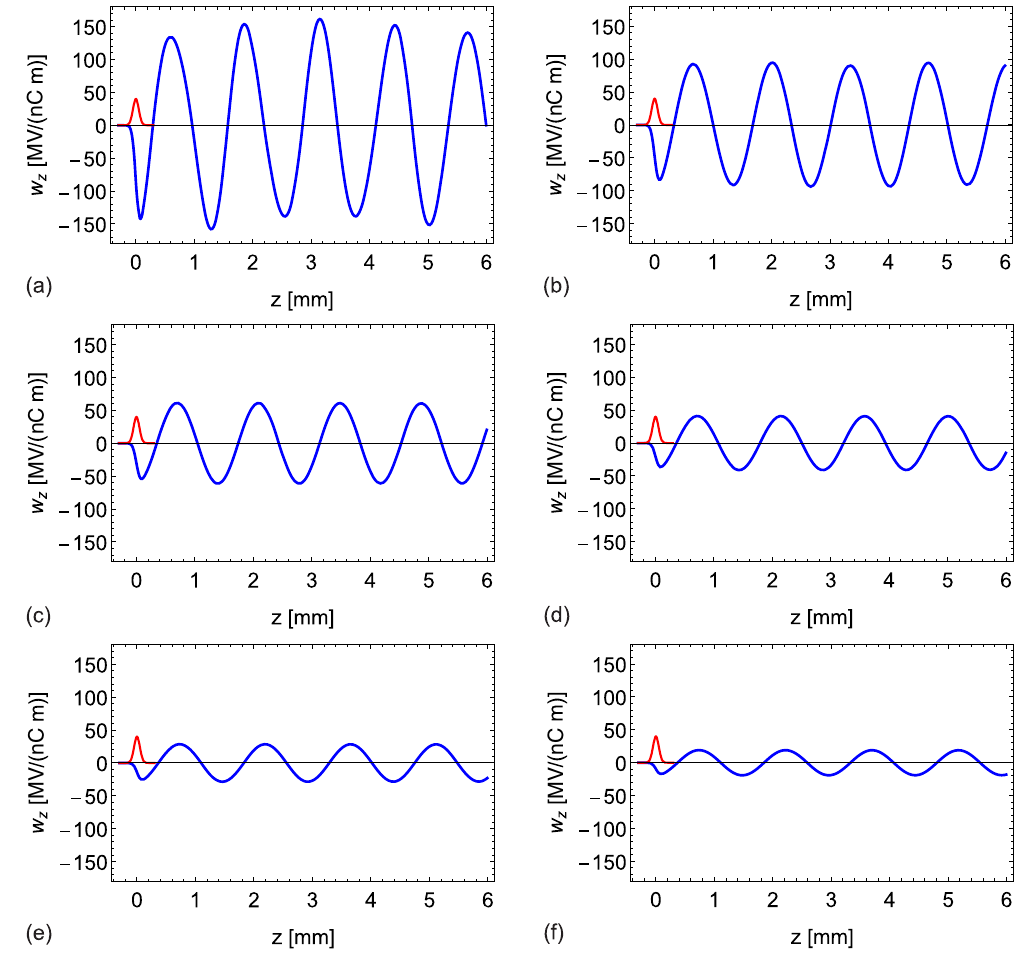
FIG. 8. Longitudinal decelerating wakefield (blue curve), electron bunch shape (red curve), of the 235 GHz structure, for 0.3 mm gap (a), for 0.5 mm gap (b), for 0.7 mm gap (c), for 0.9 mm gap (d), for 1.1 mm gap (e), and for 1.3 mm gap (f), calculated using the HFSS+ Mathematica method